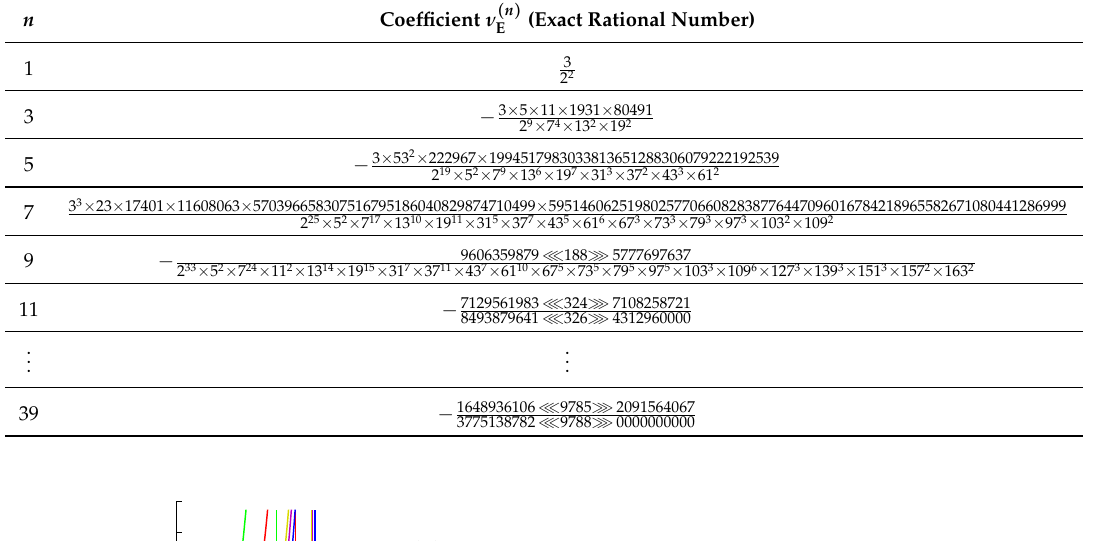
Table 1. The first 39 non-zero coefficients of (6) for the decorated hexagonal flow (DHF, prime decomposition where presented). The first 5 significant figures of these coefficients are given in [31]. ” a ≪ p ≫ c ” denotes a natural number containing p decimal digits between a and b .